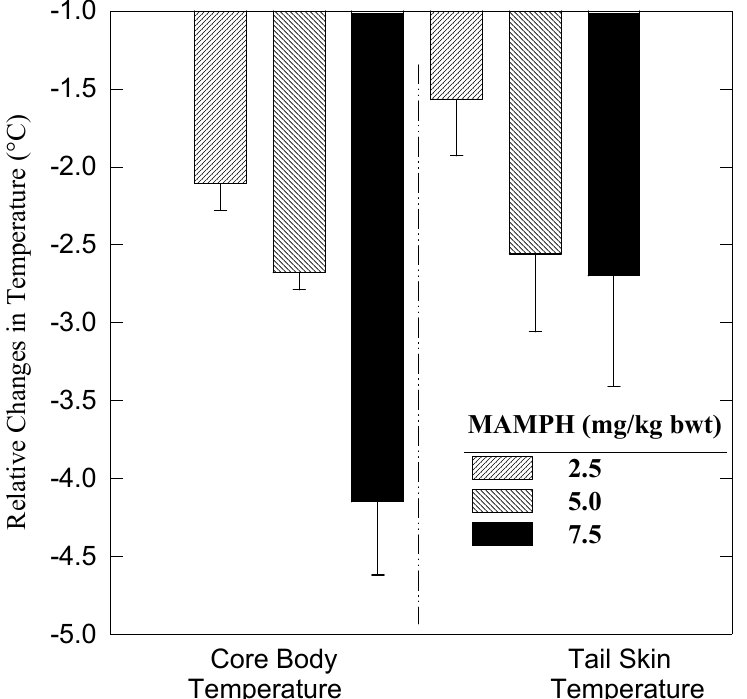
Figure 4. Effects of methamphetamine on core body and tail skin temperature one hour after drug injection at 7±